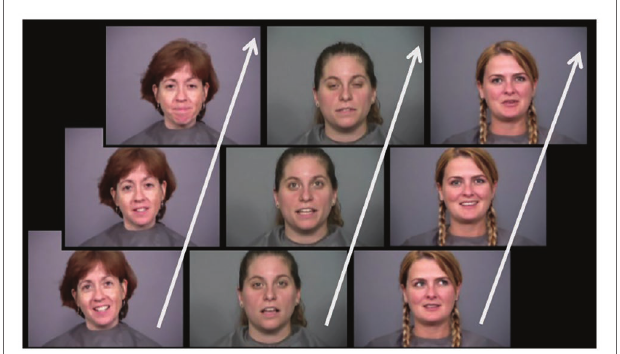
FIGURE 1 | Example of a visual search array consisting of elastically moving faces. Note that the faces were presented as videos and not as image